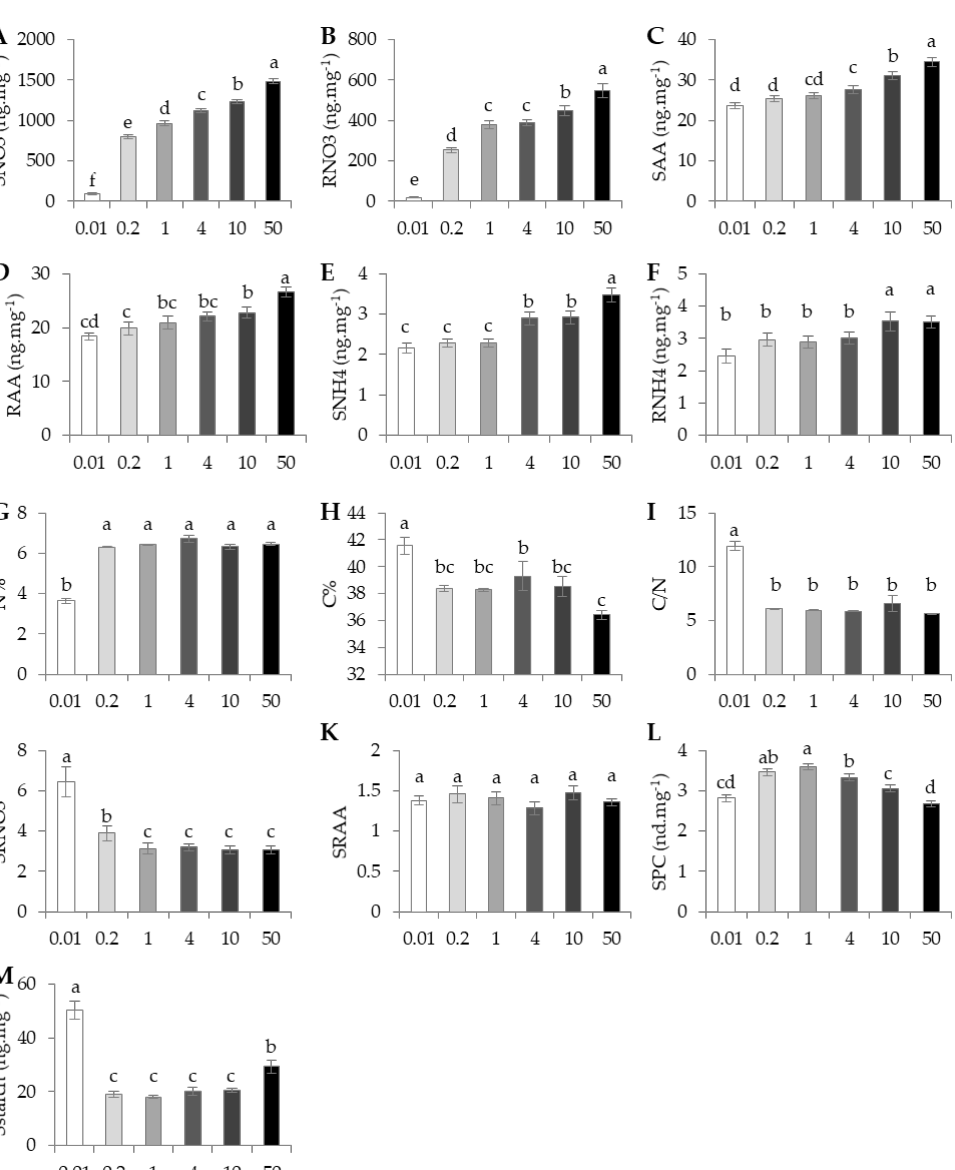
Figure 3. Average of metabolic traits on four Arabidopsis accessions grown in six different NO 3 supplies. On the x axis nutrition regimes are reported in bards of different shades of grey, according to NO 3 concentration (mM). On y axis are reported shoot nitrate (( A )-SNO3), roots nitrate (( B )-RNO3), shoot amino acids (( C )-SAA), roots amino acids (( D )-RAA), shoot ammonium (( E )-SNH4), roots ammonium (( F )-RNH4), nitrogen percentage (( G )-N%), carbon percentage (( H )-C%), carbon to nitrogen percentages ratio (( I )-C/N), shoot-to-root nitrate ratio (( J )-SRNO3), shoot-to-root amino acids ratio (( K )-SRAA), shoot protein content (( L )-SPC) and shoot starch (( M )-Sstarch). Different letters indicate values significantly different at p < 0.05.